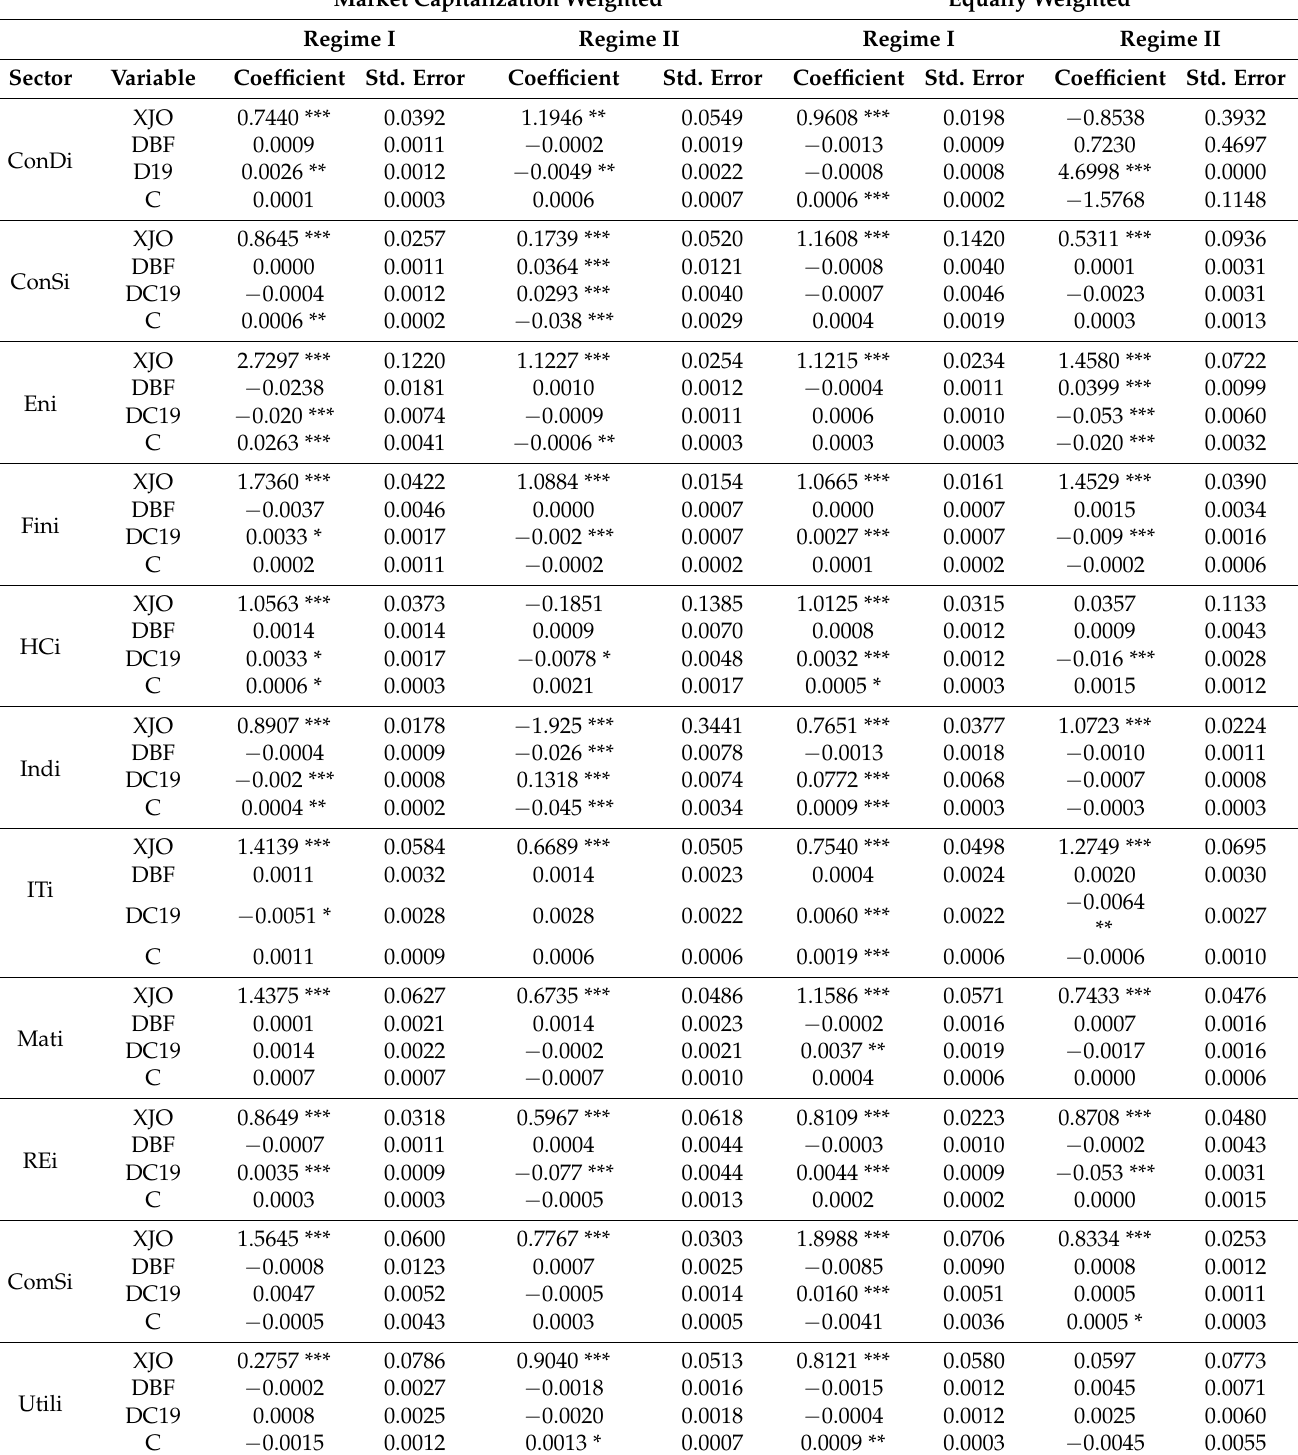
Table 5. Markov regime-switching (MRS) regression analysis